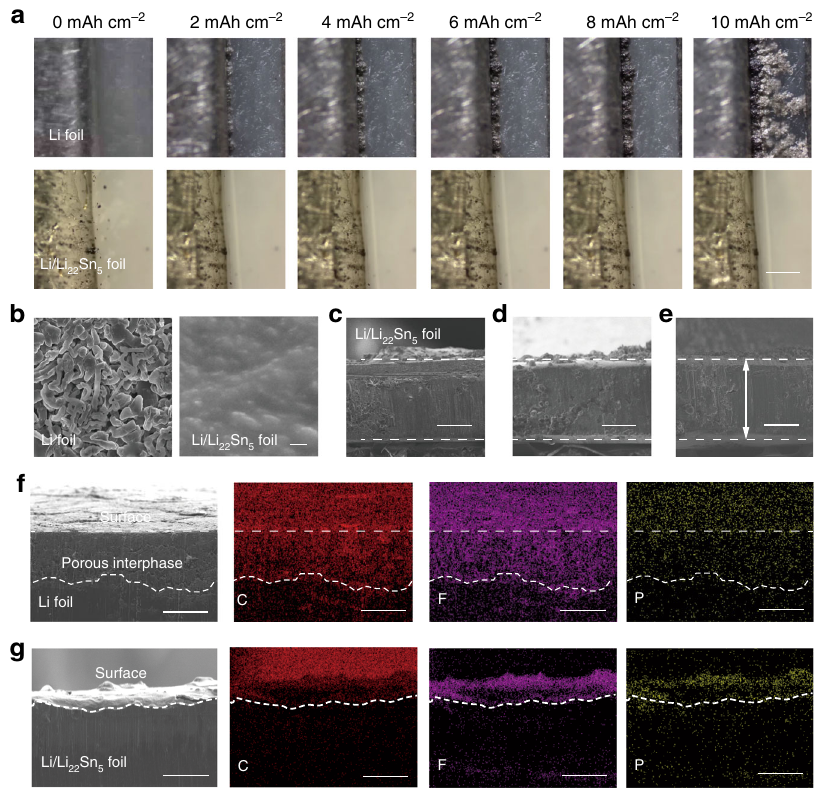
Fig. 4 Optical microscopy and SEM investigation of Li/Li 22 Sn 5 electrode. a In situ optical microscopy investigation of the interfaces between the electrolyte and electrode for the Li|Li (up) and Li/Li 22 Sn 5 |Li/Li 22 Sn 5 (down) symmetric cells during lithium plating process (1 mA cm − 2 , 10 mAh cm − 2 ) (scale bar, 300 μ m). b Top view SEM images of Li foil (left) and Li/Li 22 Sn 5 foil (right) after a stripping/plating cycle with 5 mAh cm − 2 of lithium under 5 mA cm − 2 (scale bar, 1 μ m). c – e Cross-sectional SEM images of a Li/Li 22 Sn 5 foil before electrochemical lithium stripping/plating cycling ( c ), after stripping 10 mAh cm − 2 of lithium under 5 mA cm − 2 ( d ), and after a stripping/plating cycle with 10 mAh cm − 2 of lithium under 5 mA cm − 2 ( e ) (scale bar, 200 μ m). f , g Cross-sectional SEM images and the corresponding EDX mapping images of a Li foil ( f ) and a Li/Li 22 Sn 5 foil ( g ) after 50 stripping/plating cycles with 5 mAh cm − 2 of lithium under 5 mA cm − 2 (scale bar, 50 μ